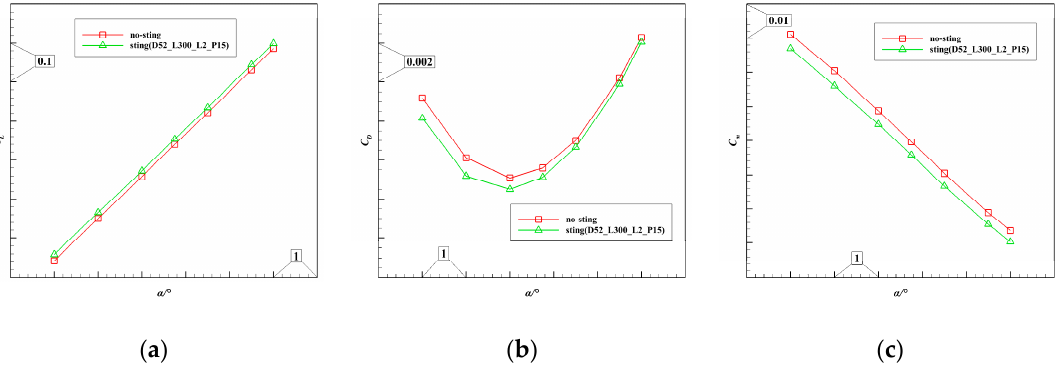
Figure 5. Aerodynamic characteristics of the BWB aircraft with and without the V-shaped support ( Ma = 0.75): ( a ) C L - α curves; ( b ) C D - α curves; ( c ) C m - α curves.